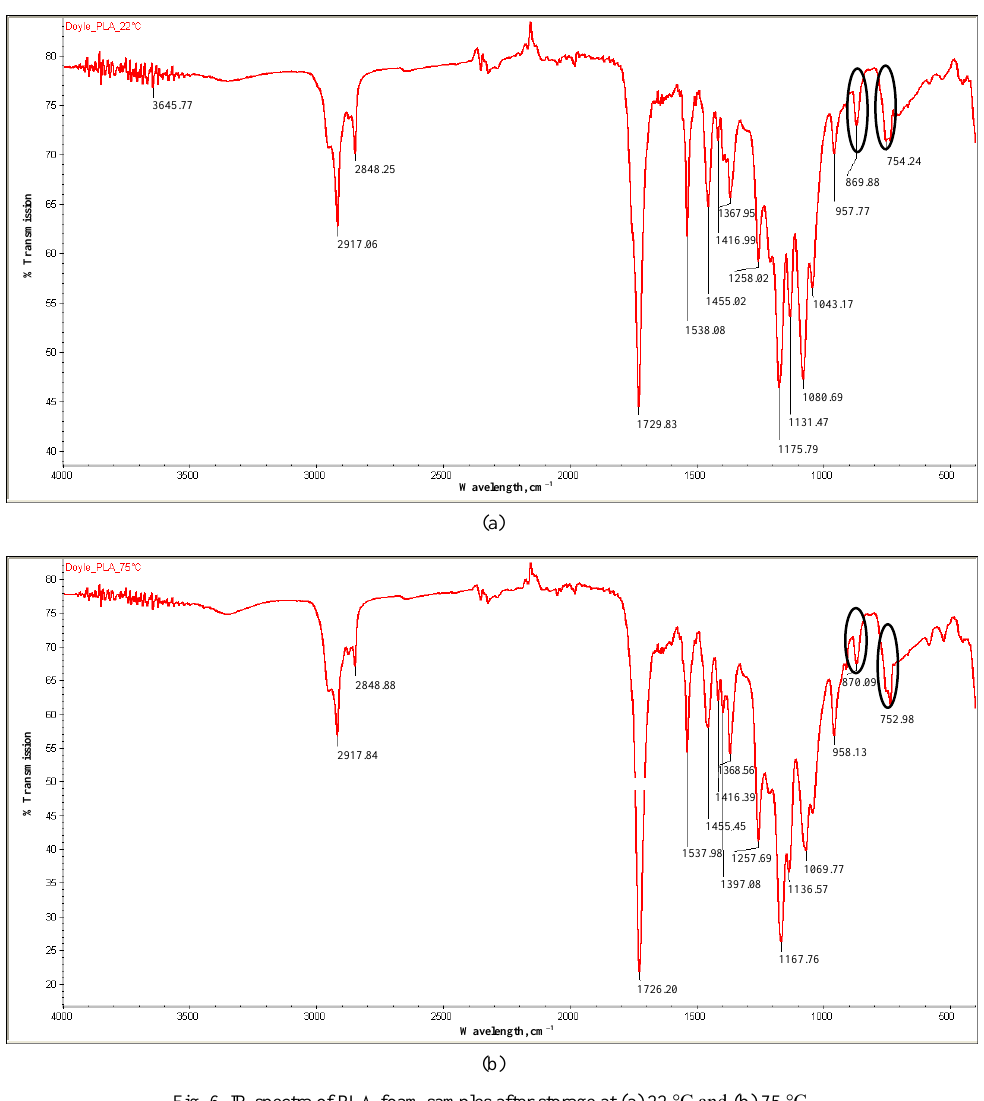
Fig. 6. IR spectra of PLA foam samples after storage at (a) 22 °C and (b) 75 °C. The peaks corresponding to the amorphous and crystalline phases are